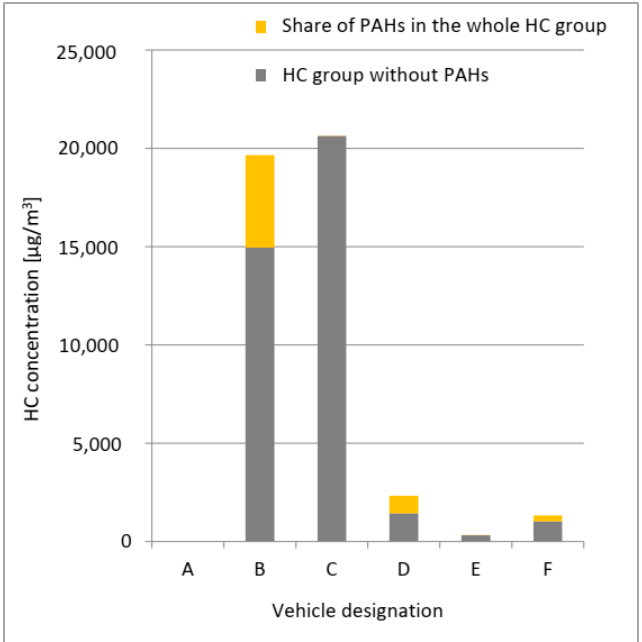
Figure 7. Share of polycyclic aromatic hydrocarbons (PAHs) in the hydrocarbon (HC) group. For vehicle A, no increase in HC was observed during the operation of the engine.